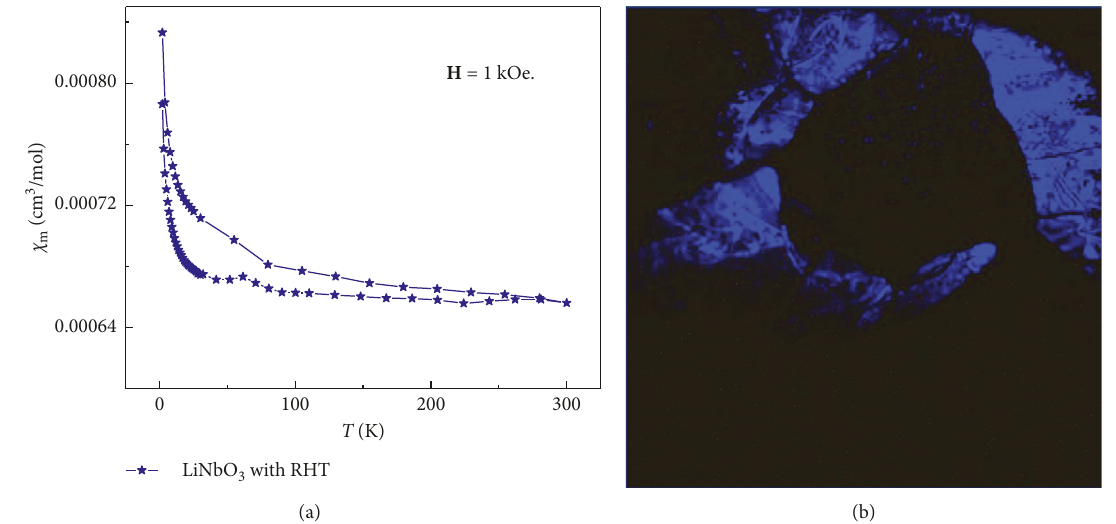
Figure 8: (a) Magnetic susceptibility of multiferroic LiNbO nanocrystals ceramic